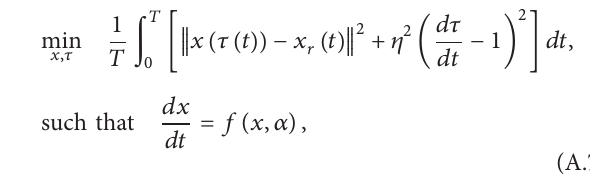
performance measure ⟨𝐽(𝛼)⟩ is of the most interest for